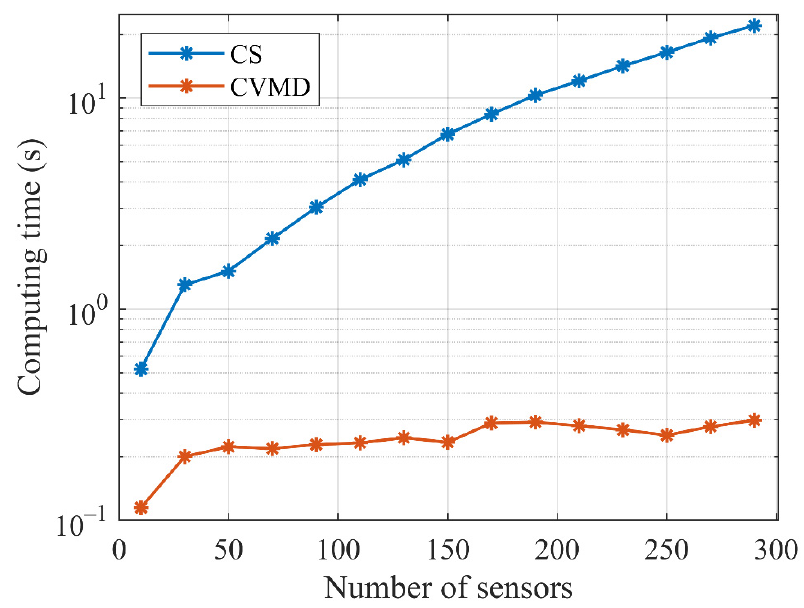
Figure 4. Comparison of computation time for two sources between the CS and CVMD-based methods with the different number of sensors.